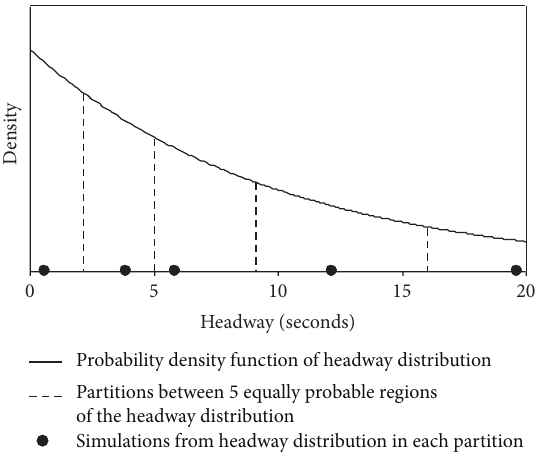
Figure 1: Simulated vehicle headways using LHS.